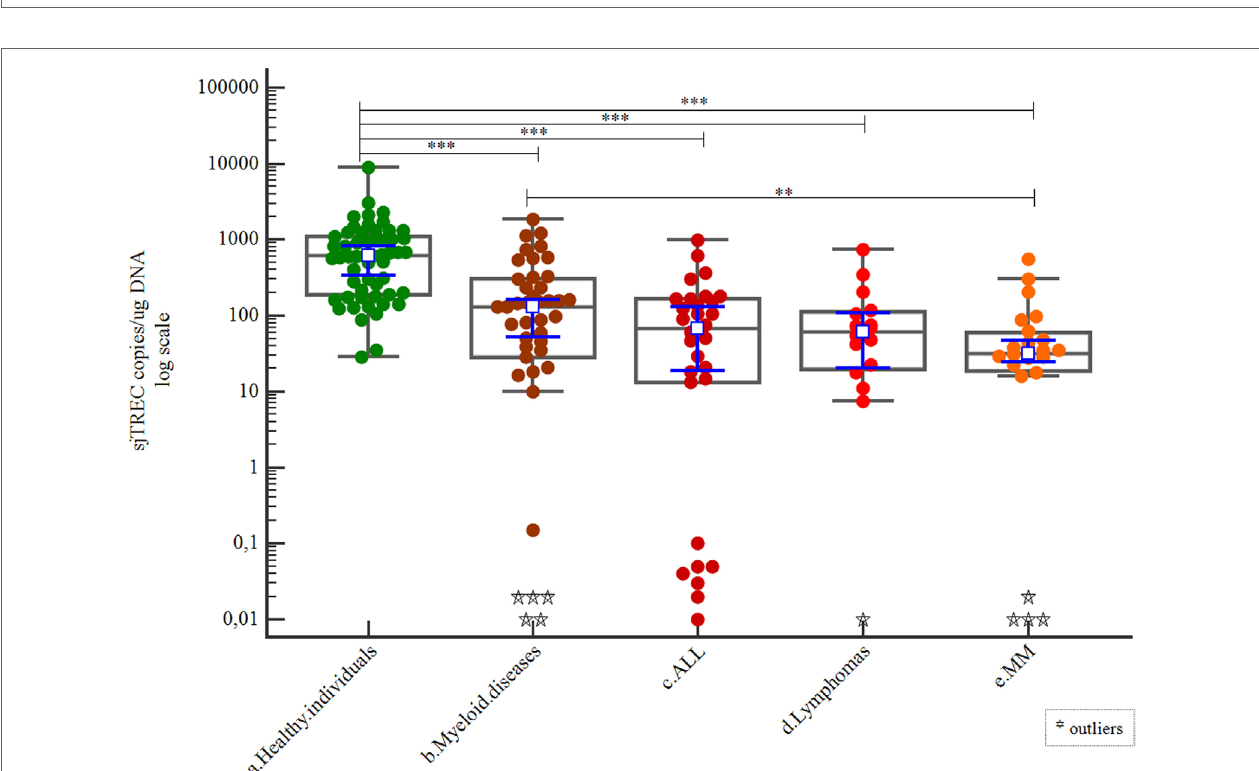
FigUre 5 | Correlations of signal joint TREC (sjTREC) count among healthy individuals and patient disease